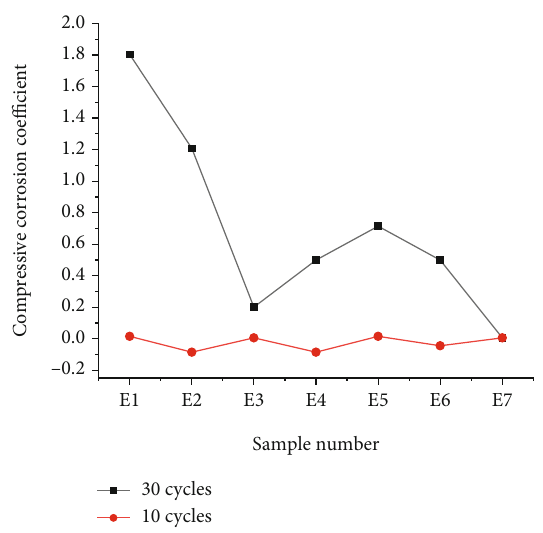
Figure 4: Mass loss rate of the accelerated sulfate corrosion cycle of pile foundation